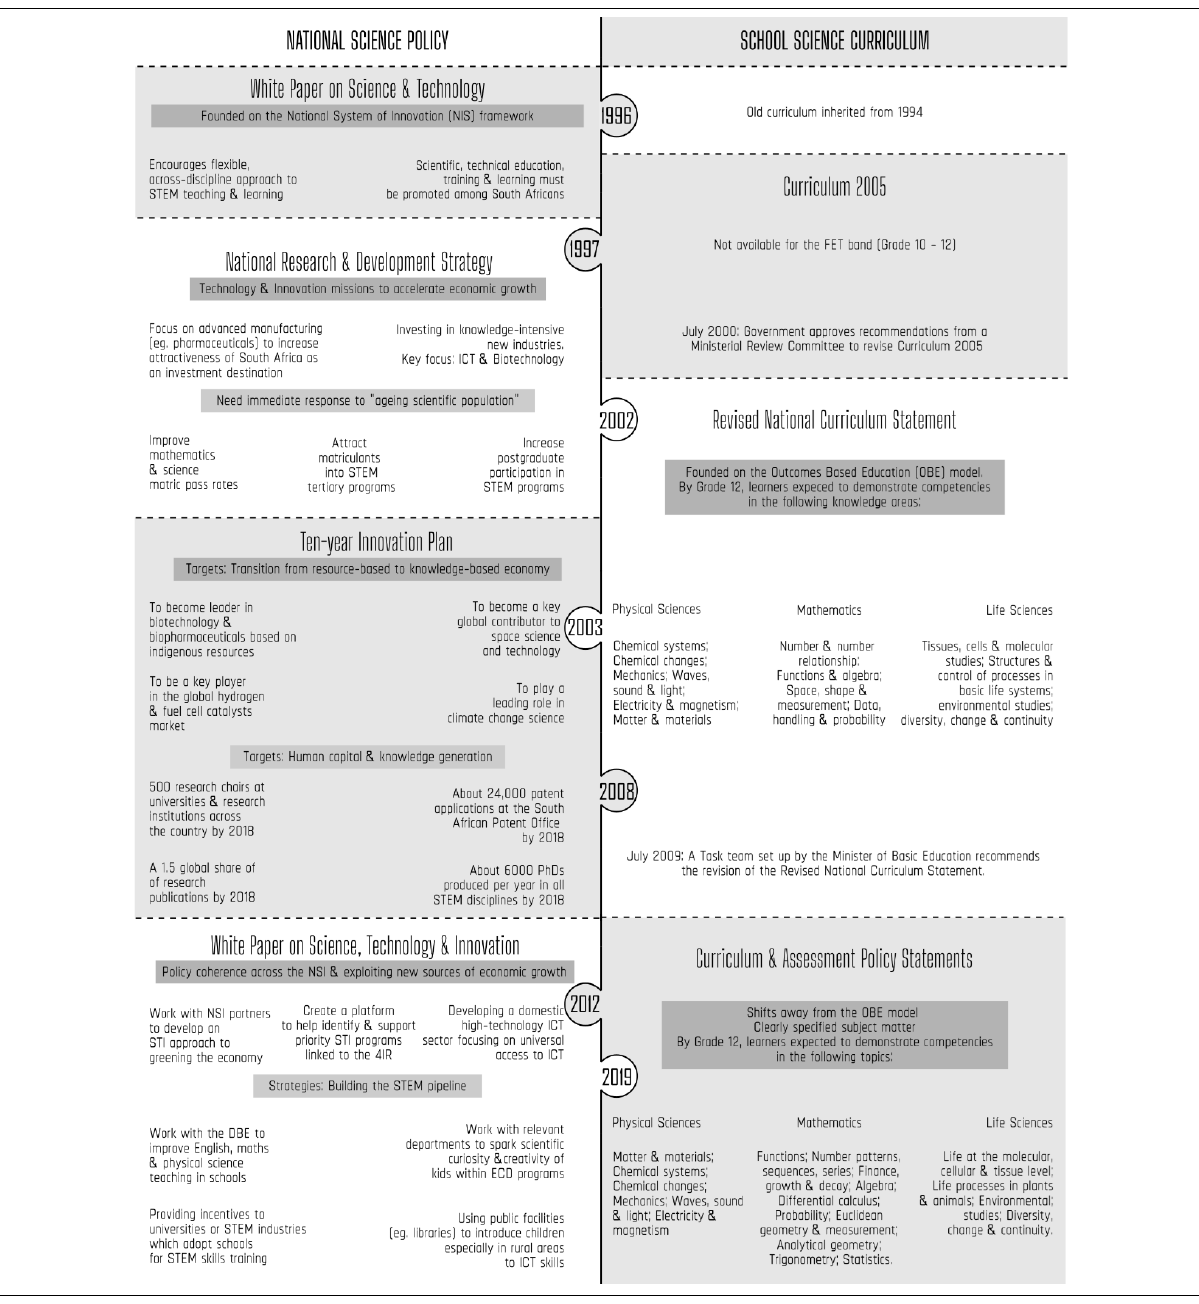
Figure 1: The response of the national science curriculum to changes in national science